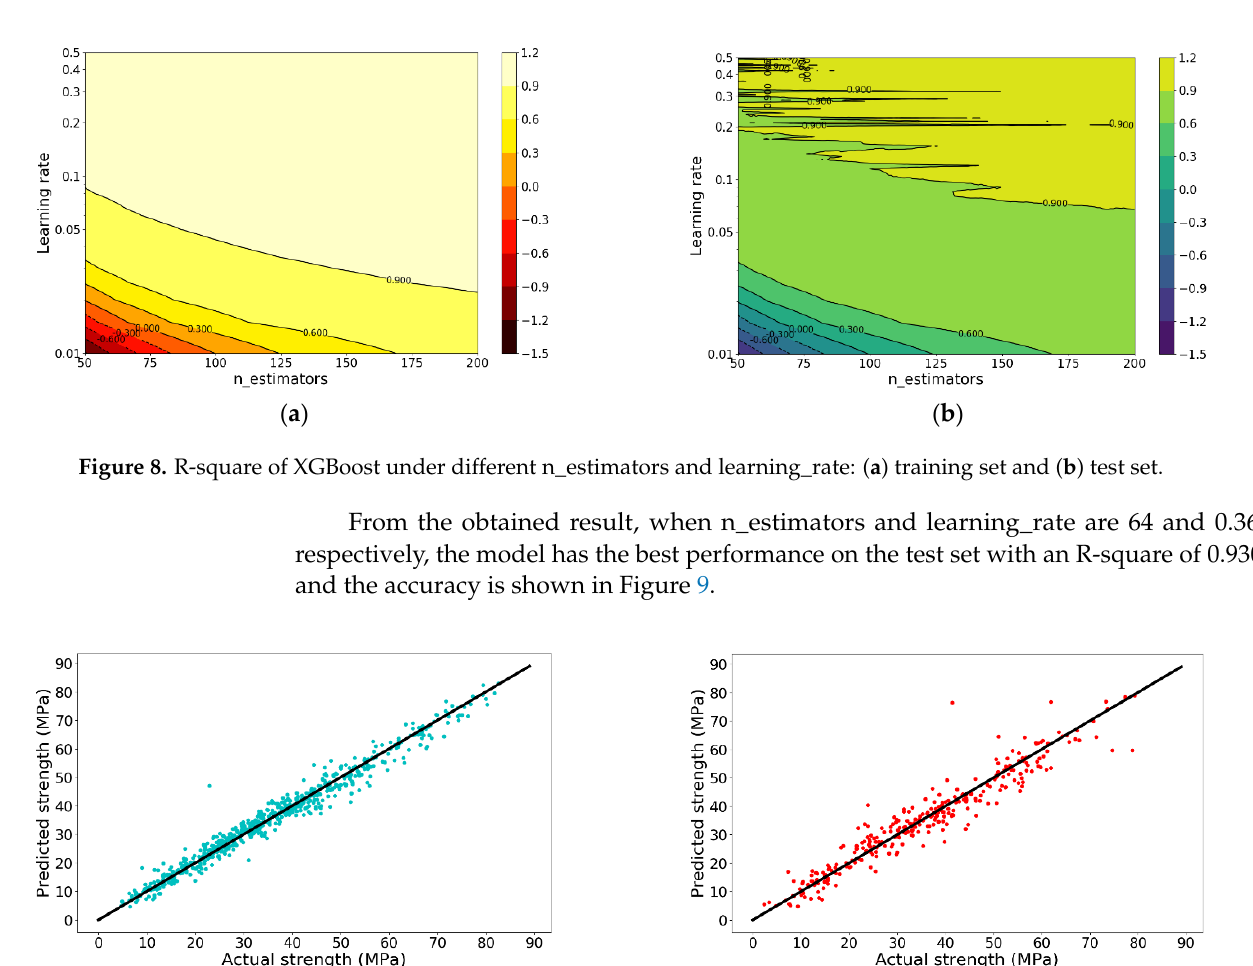
Figure 9. Prediction accuracy of XGBoost: ( a ) training set and ( b ) test set.